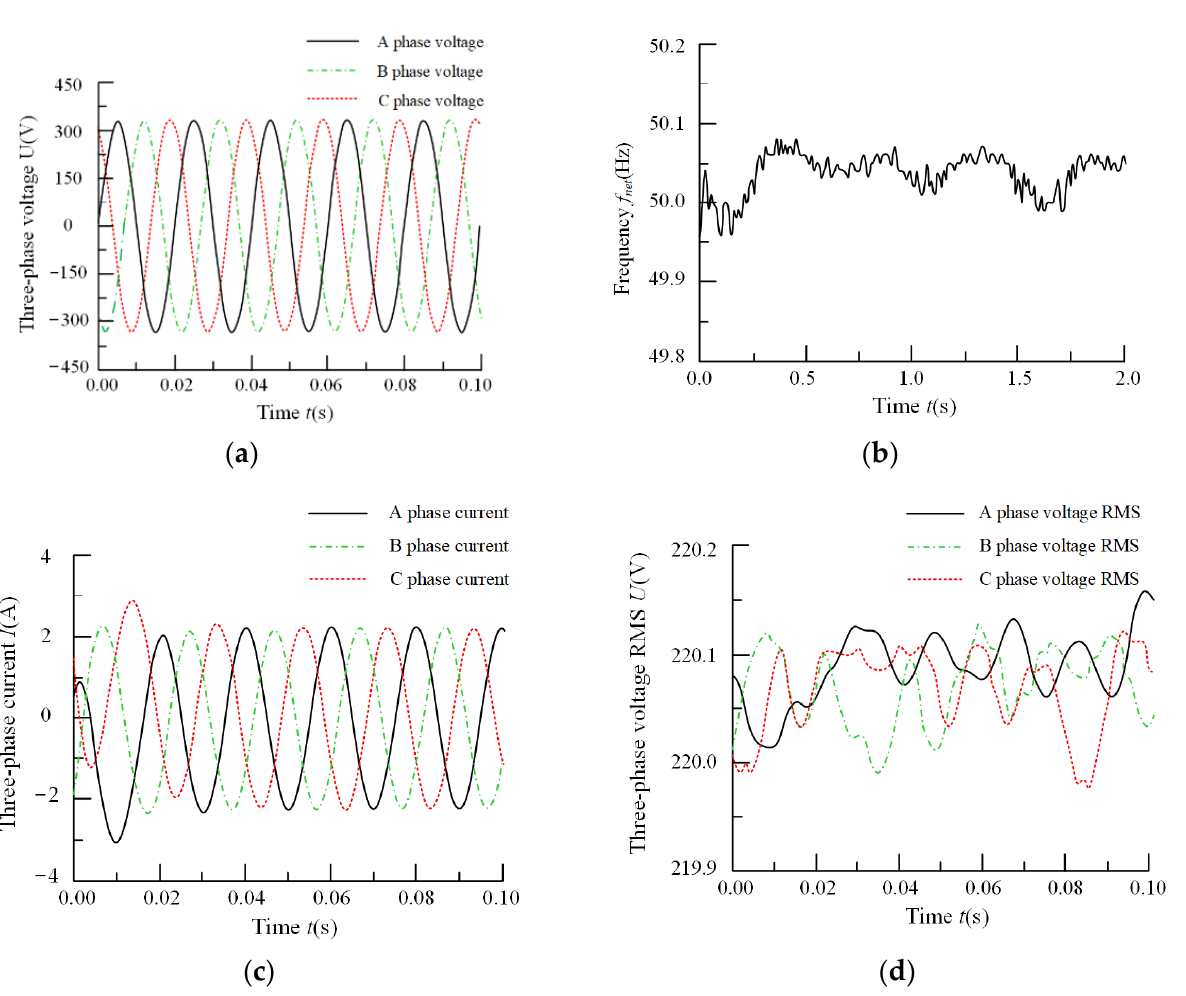
Figure 22. Power grid simulation results under normal operating conditions. ( a ) Three-phase voltages.